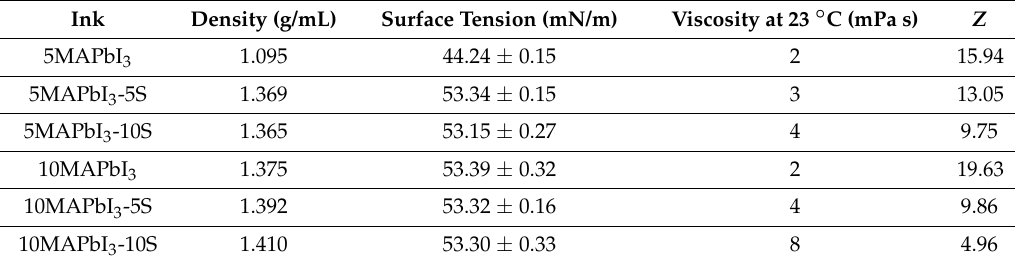
Table 2. Density, surface tension, viscosity, and Z parameter of the inks